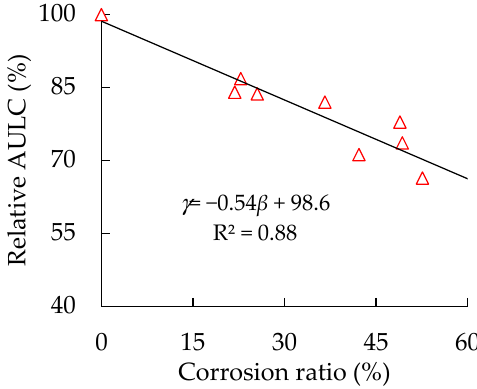
Figure 7. Relationship between specimens’ relative axial ultimate load-bearing capacity (AULC) and steel tube corrosion ratios.